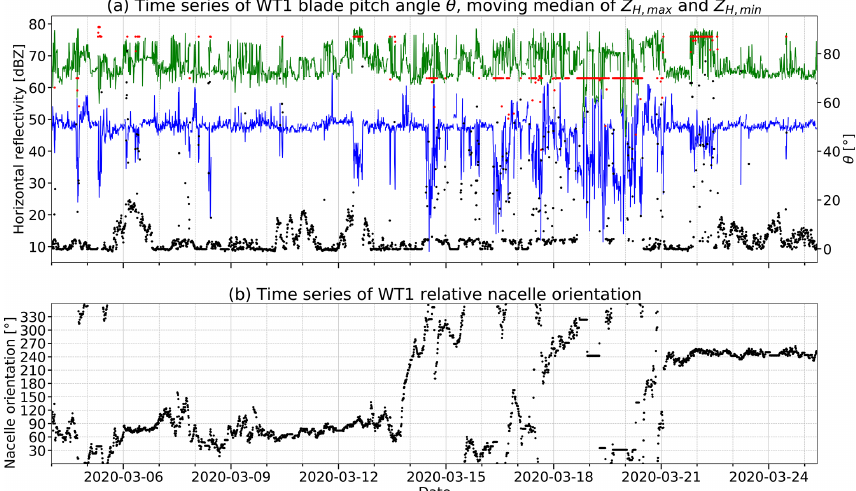
Figure 12. The line plots in (a) show the 10min moving maximum (green) and minimum (blue) of [ Z H ] = dBZ as presented in Fig. 8. The black ( r s ≥ 1rpm) and red ( r s < 1rpm) scatterplots indicate the WT1 blade angles with a temporal resolution of 10min. The time period between 4 and 25 March 2020 covers the whole 2020 field campaign. For practical reasons, plot (b) presents the relative nacelle orientation according to plot (a) .